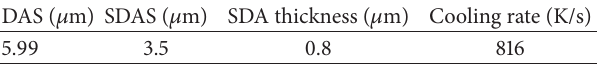
Table 5: The results from SDAS and cooling rate measurements for sample number